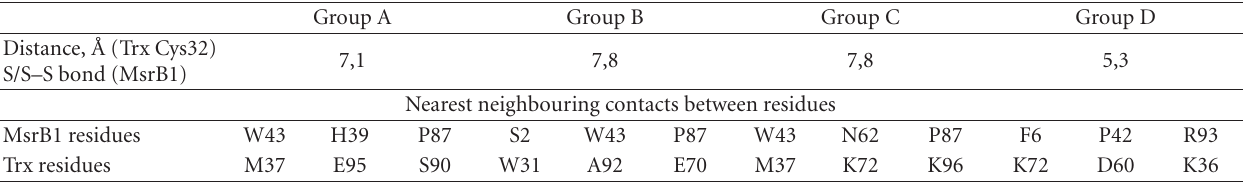
Table 1: Structural parameters for MsrB1-Trx complexes (four groups) revealed by protein docking. The distances between sulphur atom of Cys32 of Trx and the nearest sulphur atom of MsrB1 disulfide bond as well as three pairs of the nearest aminoacids approaching in space for each group (to outline the spatial orientation of the proteins within a complex) are presented.